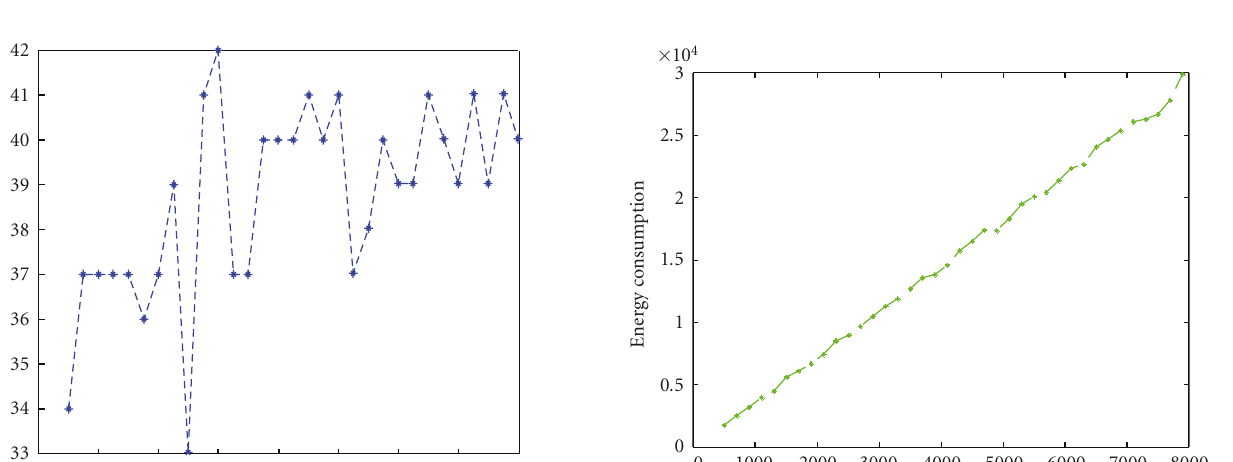
Figure 6: Relation between r 1 /r 2 and cluster head distribution